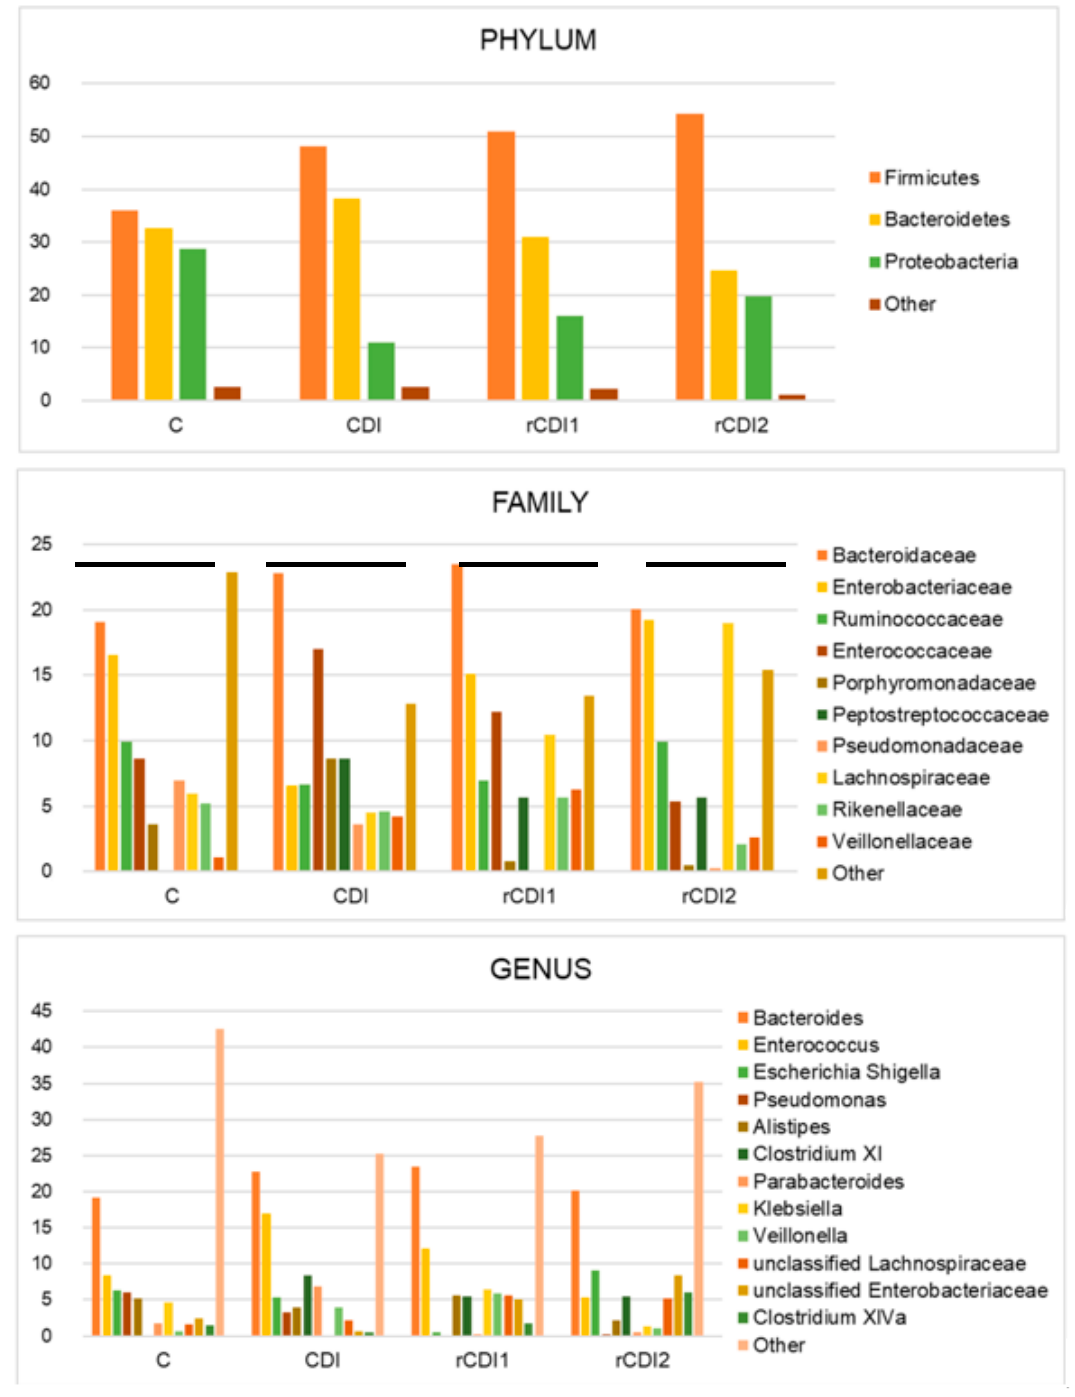
Figure 1. Taxonomic composition of the gut microbiota in non-recurrent and recurrent C. difficile infection as compared to non-infected controls. Average relative abundances of the most represented phyla, families and genera identified in the four study groups. C = non-infected controls; CDI = non-recurrent C. difficile infection; rCDI1 = recurrent C. difficile infection, first episode; rCDI2 = recurrent C. difficile infection, second episode. Only taxa whose relative abundance was >5% in at least one group were included.